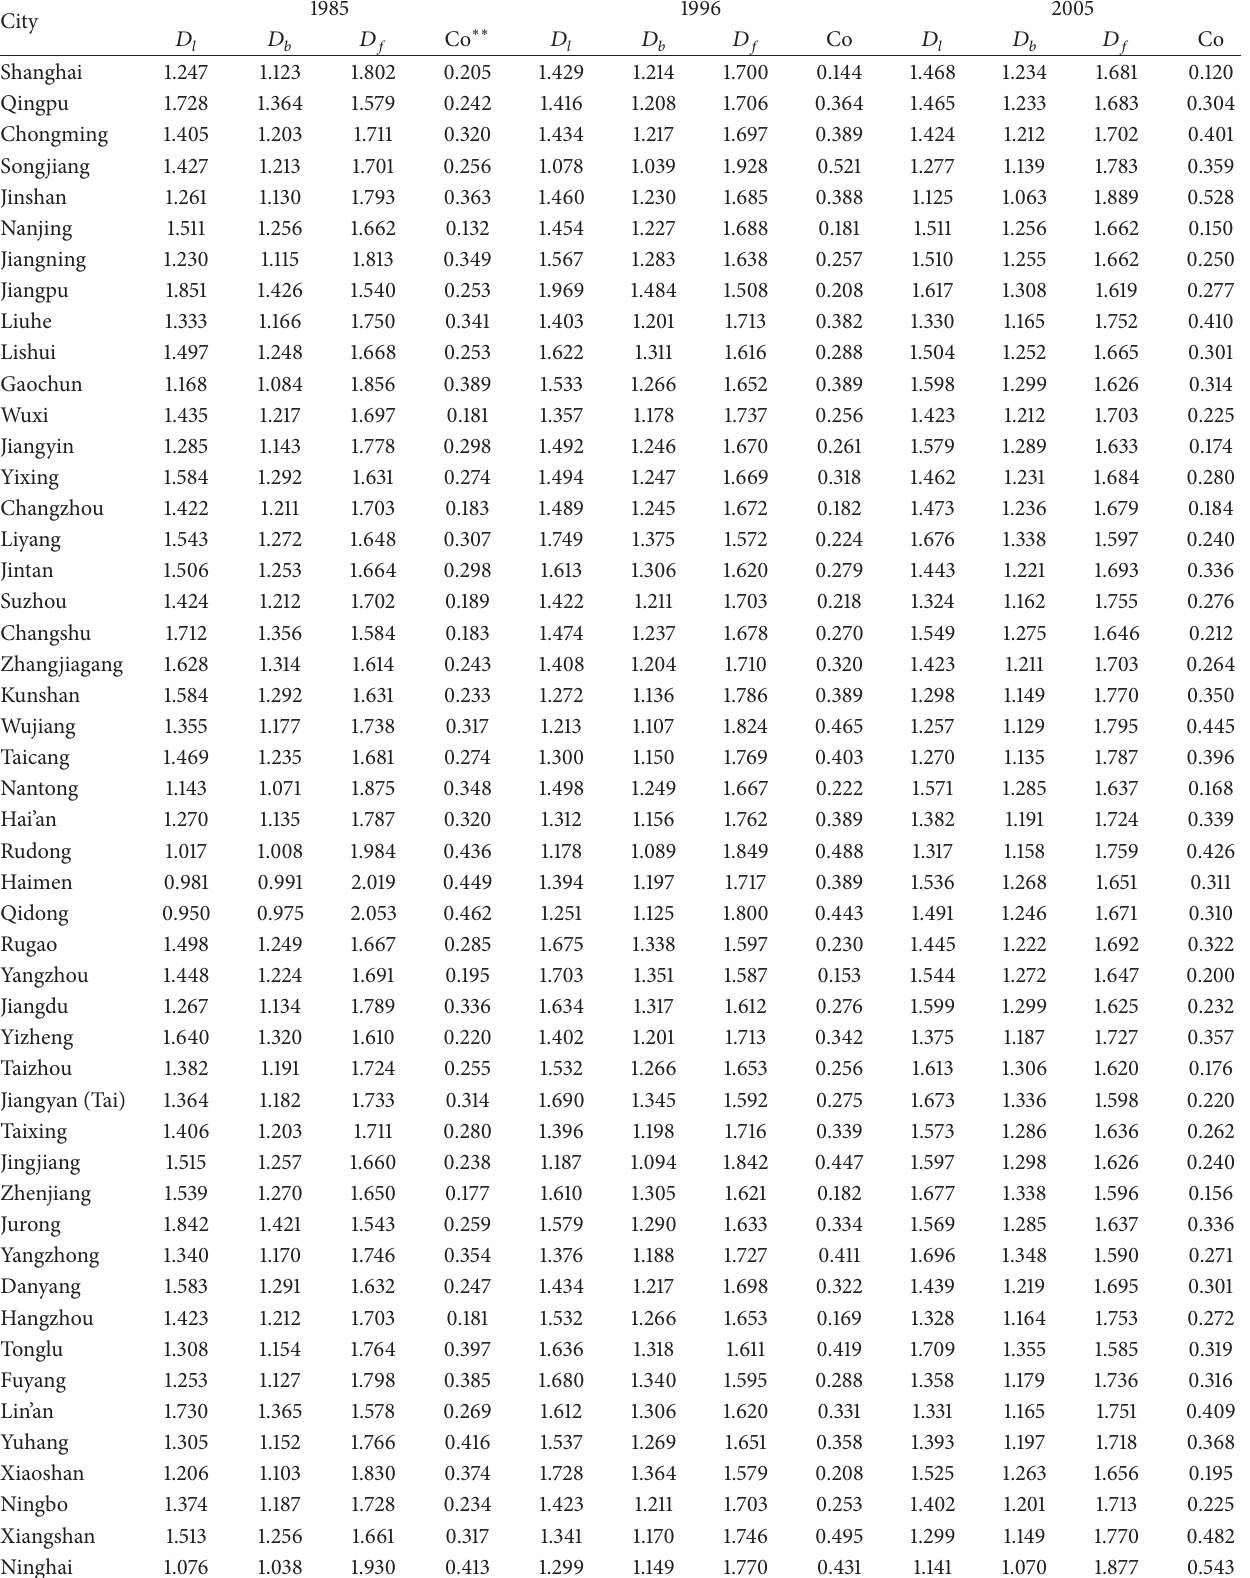
Table 3: The local fractal parameters of the cities and towns in Yangtze River Delta, China (1985–2005). City